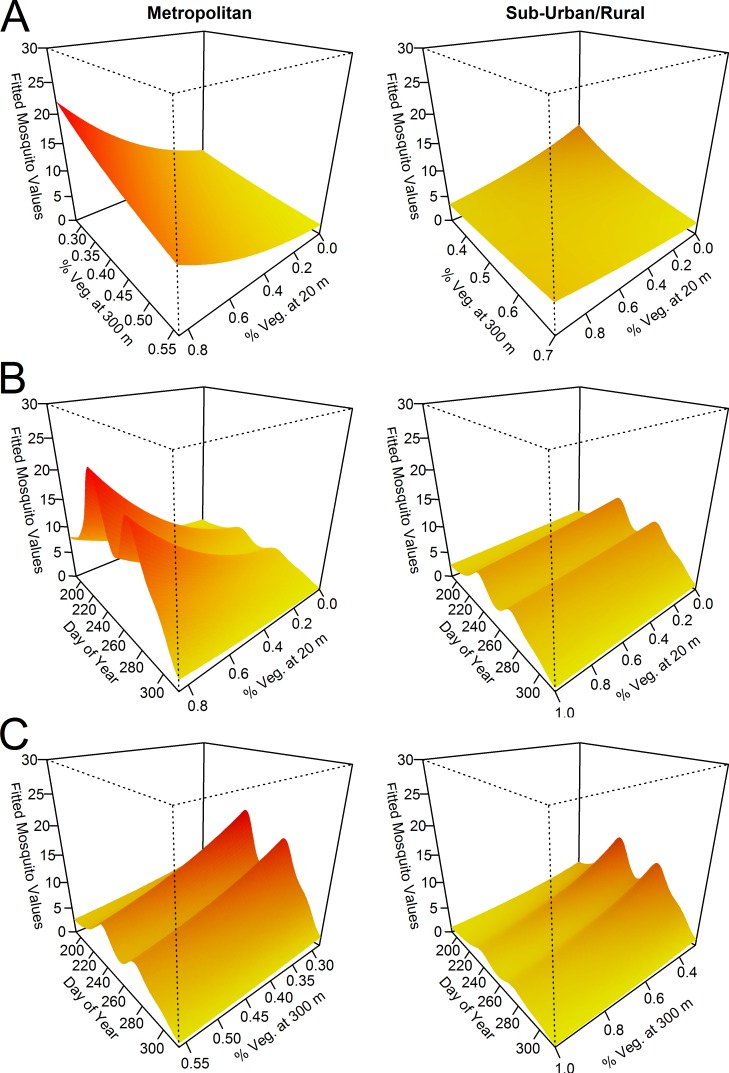
Fitted values (GAMM) of Aedes albopictus female abundance in metropolitan and sub-urban/rural environments in Rome.Left column = Metropolitan Environment; right column = Sub-Urban/Rural Environment. Fitted mosquito values (Z-axis) = fitted values of females/station/week. A: interaction between Vegetation Covers at 20 m and at 300 m buffers (scaled to the 0–1 interval) conditional to Days of the Year (DoY, considered at its mean values); B: interaction between Vegetation Cover at 20m and DoY conditional to vegetation cover at 300m (considered at mean values); C: interaction between Vegetation Cover at 300m and DoY conditional to Vegetation Cover at 20m (considered at mean values). Variables presented on the original scale (i.e. not centred).